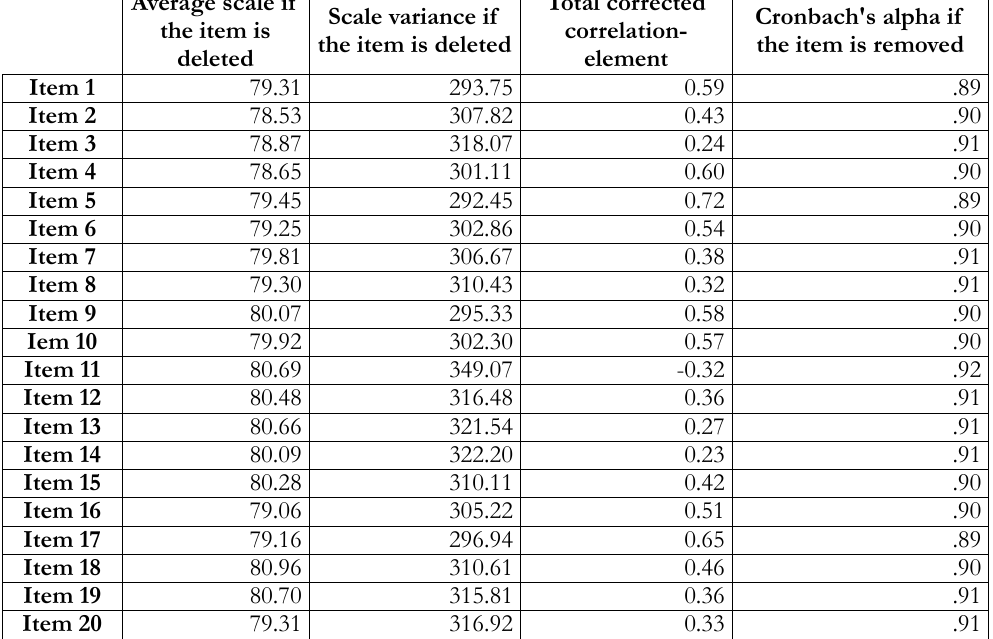
Table 3. Correlation items with total